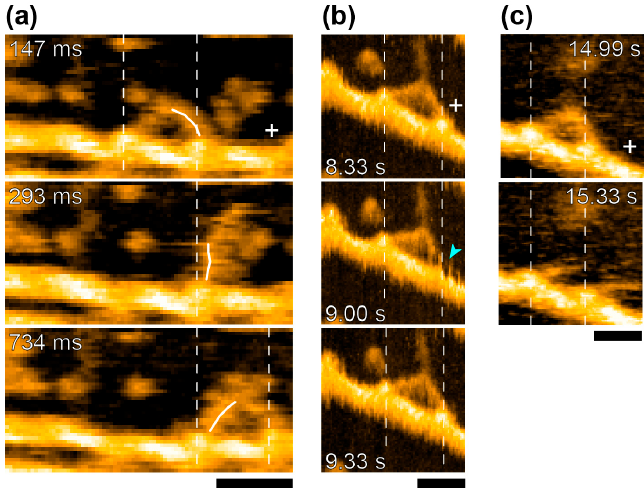
Figure 6. Dynamic behavior of myosin-V HMM captured by HS-AFM. ( a ) Hand-over-hand movement and the swinging lever-arm motion of myosin-V HMM observed at 1 μ M ATP (Frame rate, 7 fps; scan area, 150 × 75 nm 2 ). The swinging lever-arm is highlighted with thin white lines; ( b ) Foot-stomping of the leading head observed at 50 μ M ADP. The detachment of the leading head is indicated by light blue arrowhead; ( c ) Myosin-V HMM observed before and after unwinding of the coiled-coil tail, at 50 μ M ADP (in ( b ) and ( c ), Frame rate, 3 fps; scan area, 90 × 90 nm 2 ). Vertical dashed lines and the plus sign represent the centers of mass of the catalytic-domains and the plus end of actin, respectively. Scale bar indicates 30 nm.